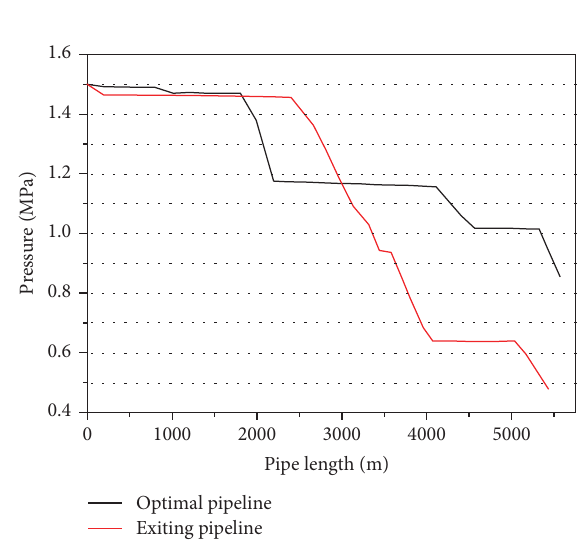
Figure 13: Pipeline route in 3D topographical map.